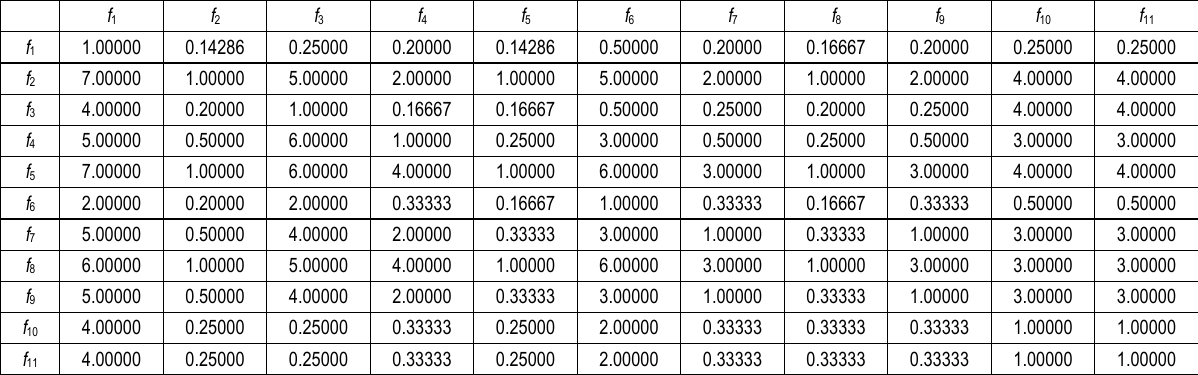
Table 4. Saaty’s matrix for savings accounts